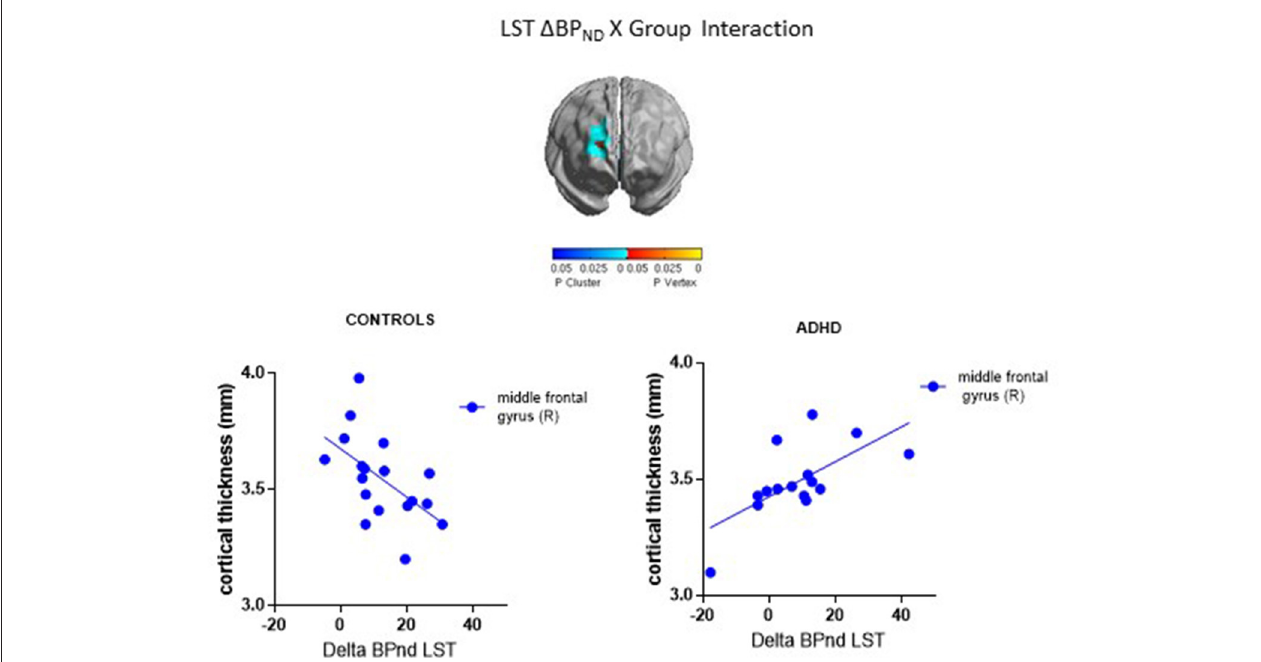
FIGURE 1 | Loci of association of 1 BP ND with cortical thickness